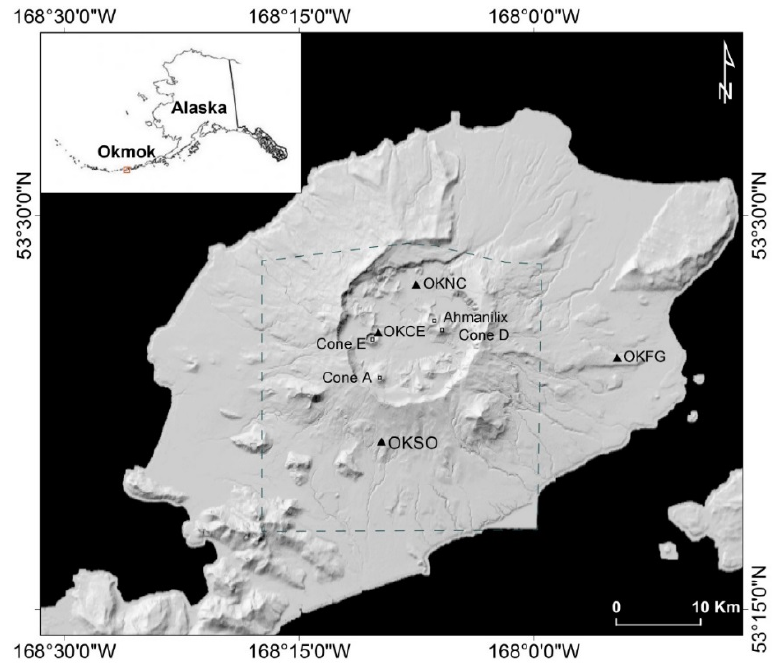
Figure 1. Shaded relief image of Okmok volcano, with some of the intra-caldera cones labelled. Cone A was the vent for historical eruptions prior to 2008, while Ahmanilix is the new cone formed during the 2008 eruption. OKSO, OKFG, OKNC, and OKCE are continuous GPS stations. The dashed blue frame shows the area of the DEM created from 21 January 2010 with Worldview imagery [8], while the remaining area topography is from the 1-arc-second (~30 m) SRTM DEM. Inset shows the location of Okmok in the central Aleutian volcanic arc.